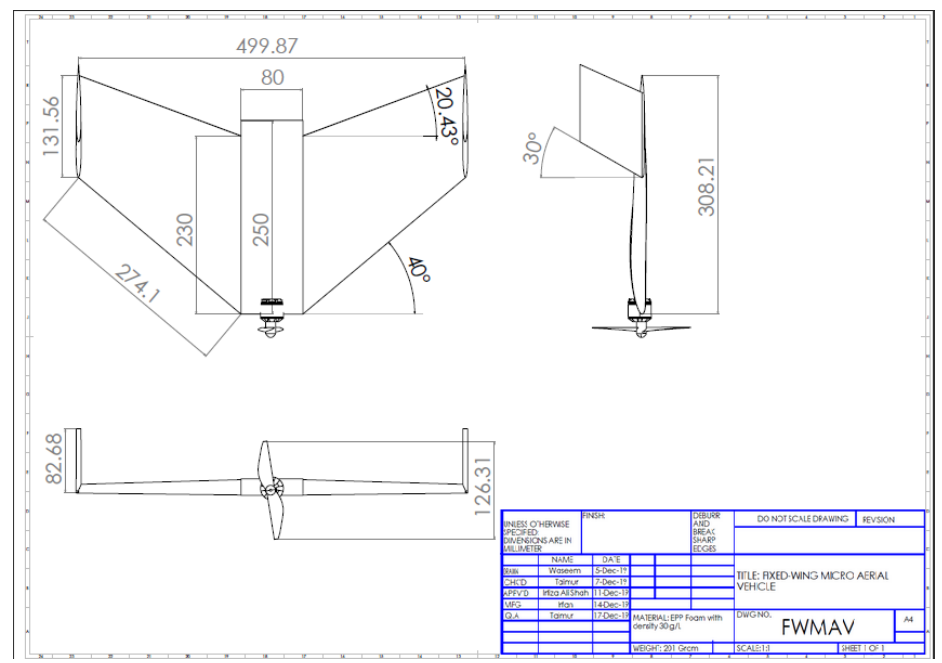
Figure 2. Detailed design features of FWMAV under consideration. All measurements are in